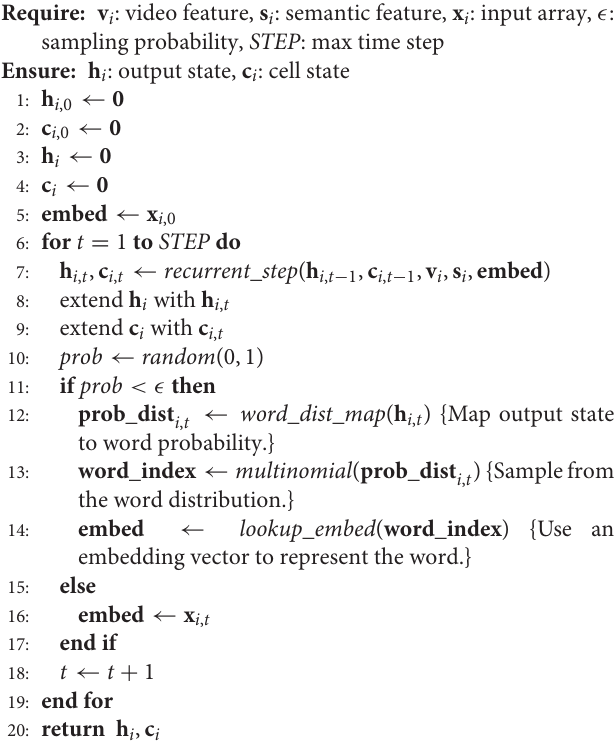
Algorithm 2: Random Sampling Algorithm: specific procedures in